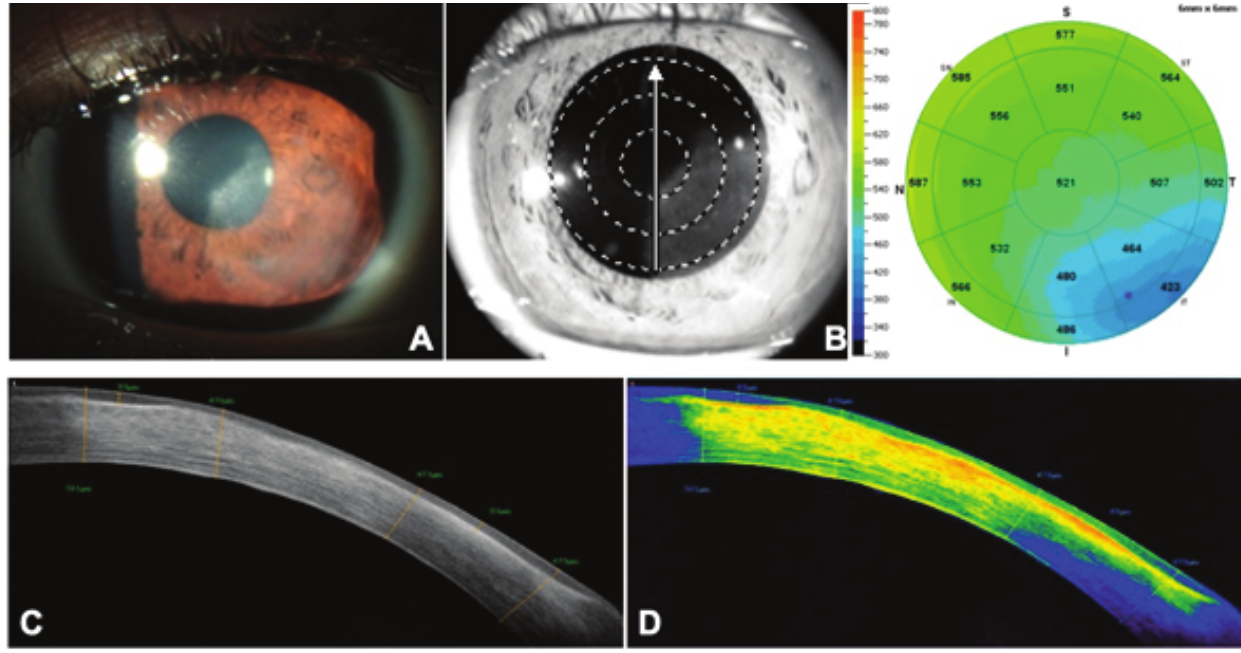
Figure 2. (A) Slit-lamp photograph of a cornea with inactive nonnecrotizing HSK, showing a diffuse leukoma with no stromal edema. (B) SD-OCT pachymetry showing a thinner cornea (min = 423 µm) in the area of the lesion. (C) A cross-sectional view of the leukoma showing areas of epithelial remodeling and thickening compensation (max = 83 µm) under areas of scarring and stromal compaction (min = 470 µm). (D) Color scale of the lesion showing higher density areas corresponding to fibrosis and scarring on the anterior and medial stroma, fading to yellow and green tones as the lesion becomes less